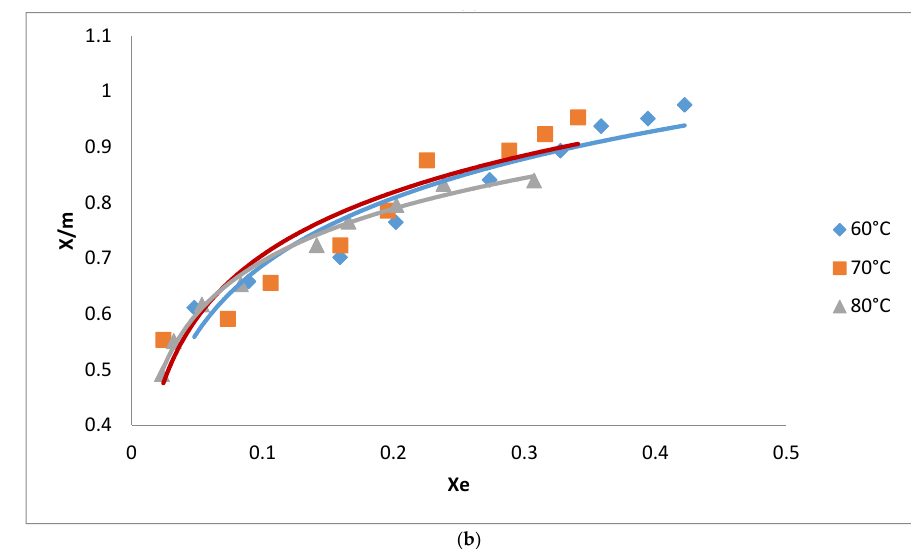
Figure 4. ( a ) Adsorption isotherm for the removal of pigments from oil using AC from cotton; ( b ) Adsorption isotherm for the removal of pigments from oil using AC from neem.